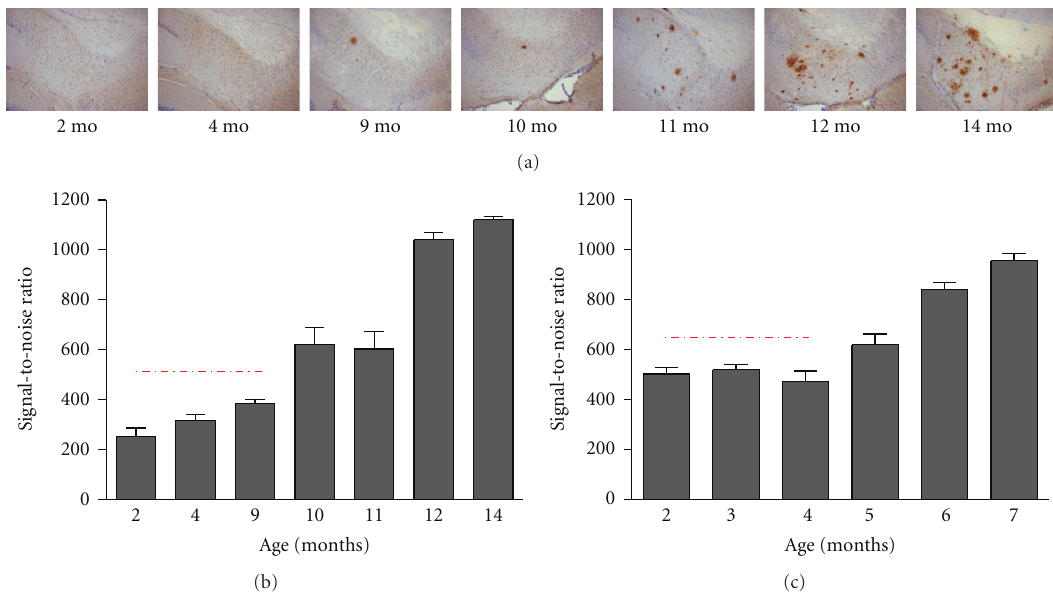
Figure 1: Abeta aggregation prior to plaque formation in APP[V717I] (APP-Ld) and APP[V717I] × PS1[A246E] mice. (a) Representative photo collection of anti-Abeta stained sections showing total plaque load in APP-Ld mice of di ff erent ages (proprietary anti-Abeta Nanobody, reMYND/Ablynx, Belgium). (b) Aggregated Abeta in APP-Ld mice of di ff erent ages, both in preplaque (indicated by the dashed line) and postplaque stages of the Alzheimer pathology (A 4 -assay, Amorfix Life Sciences Ltd., Mississauga, Canada). The signal of nontransgenic mice was under the S/N cuto ff value (data not shown). (c) As in B, for the APP[V717I] × PS1[A246E] model. The signal of nontransgenic mice was under the S/N cuto ff value (data not